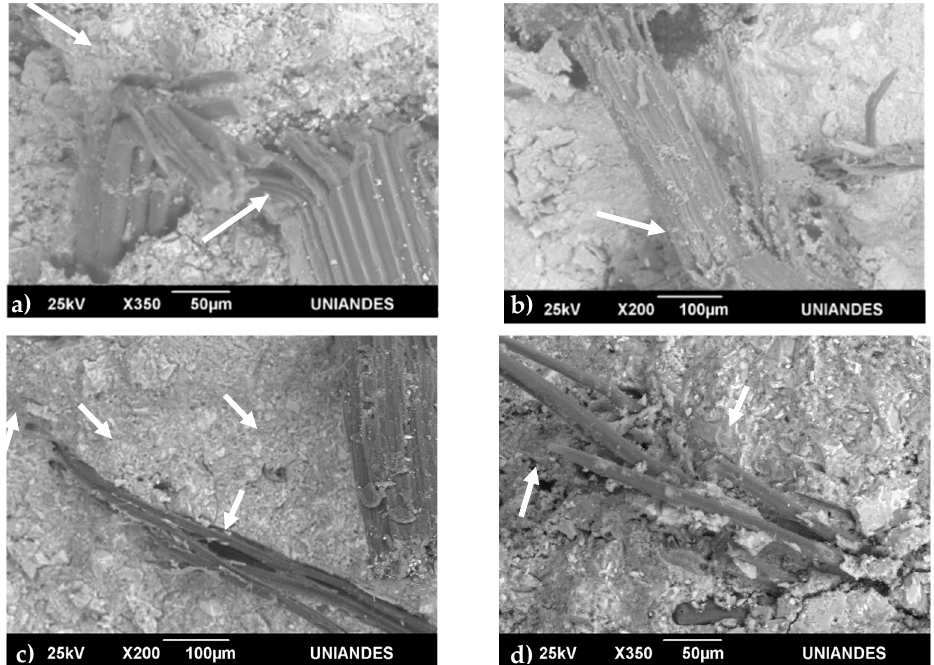
Figure 11. Scanning electron microscopy images of the fracture surfaces of composite cement boards reinforced with ( a , b ) untreated and ( c , d ) Ca(OH) 2 -treated G. angustifolia fibers, after ( a , c ) 7 and ( b , d ) 28 days.